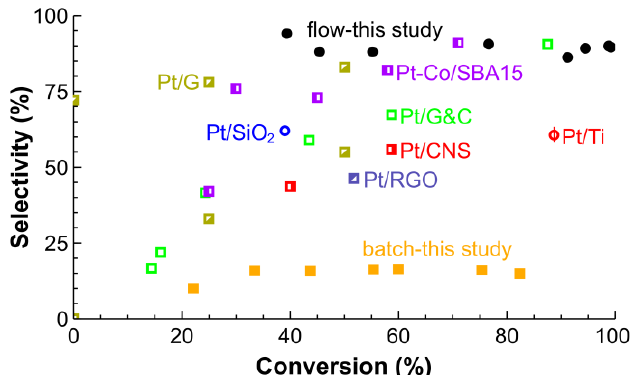
Figure 9. The selectivity to COL as a function of CAL conversion obtained in the current work over the 12 wt % Pt/SiO 2 catalyst in the tube (flow-this study, •) and batch (batch-this study, ■ ) reactors compared with the literature data in obtained in continuous flow reactors (Pt/Ti, ⏀ [35]; Pt/SiO 2 ○ [31]) and batch reactors (Pt/G&C, □ [12]; Pt-Co/SBA-15, ◧ [19]; Pt/CNS, ◨ [23]; Pt/RGO, ◩ [53]; Pt/G, ◪ [54]). Circles represent continuous flow and squares represent batch reactors.